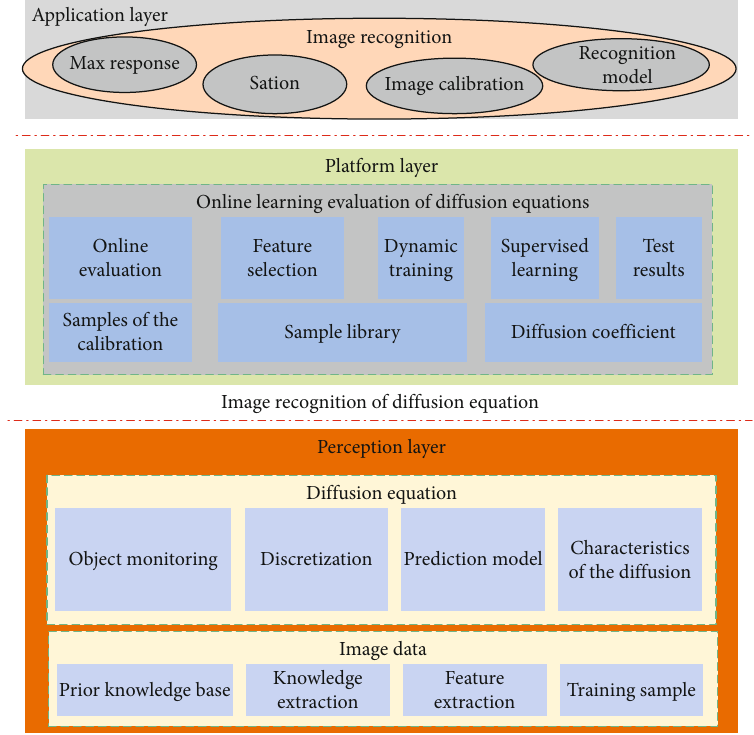
Figure 1: Image recognition framework of di ff usion